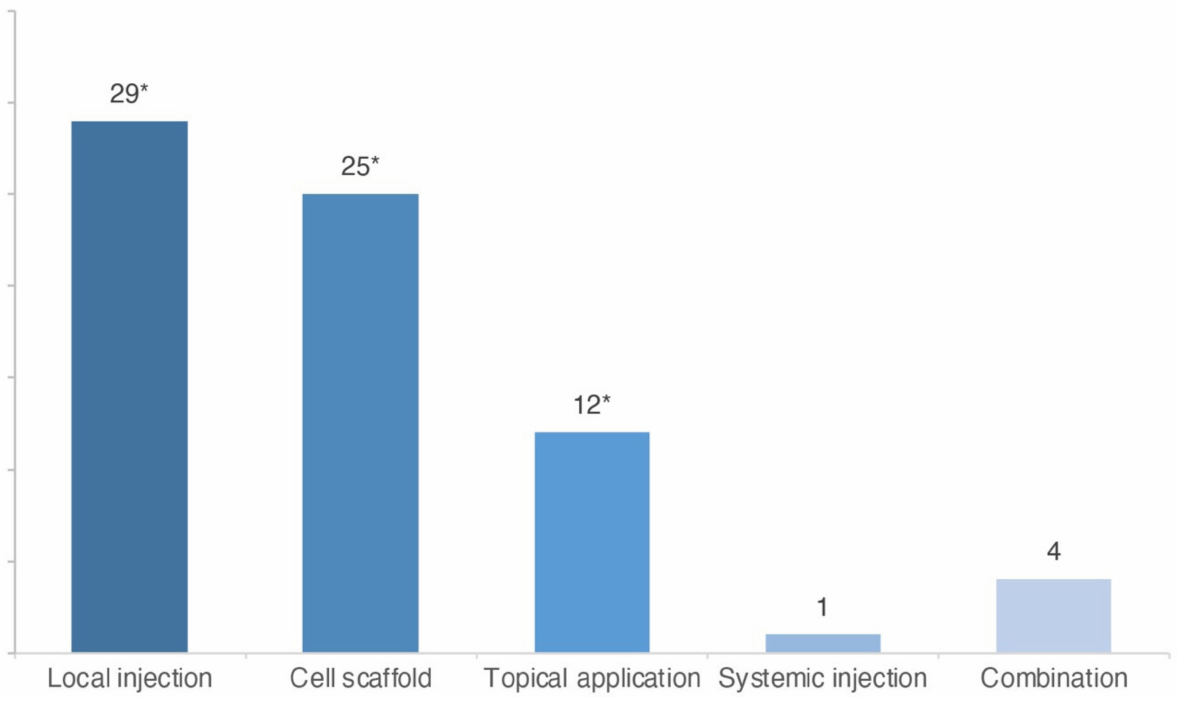
Figure 3. Administration methods in preclinical trials by category ( n = 71). * Six studies compared different administration methods between study groups in the same experiment. Therefore, these six studies are represented as thirteen different groups in the figure